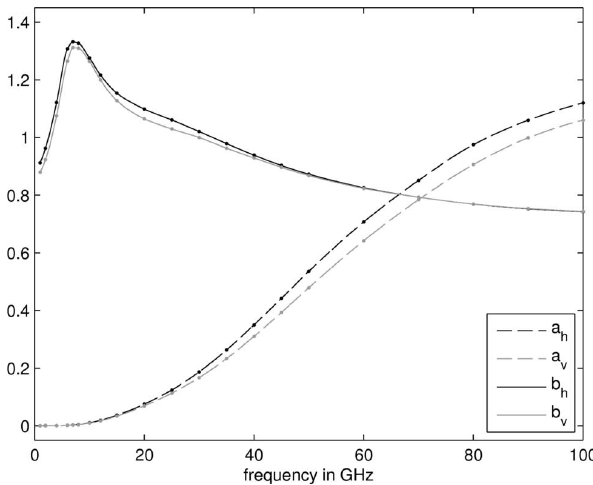
Fig. 1. Values of a and b for horizontal and vertical polarization used for the power law relation in Eq. (1). Dots are the values listed in the ITU recommendation. Lines are shape-preserving spline in- terpolations of the ITU data.